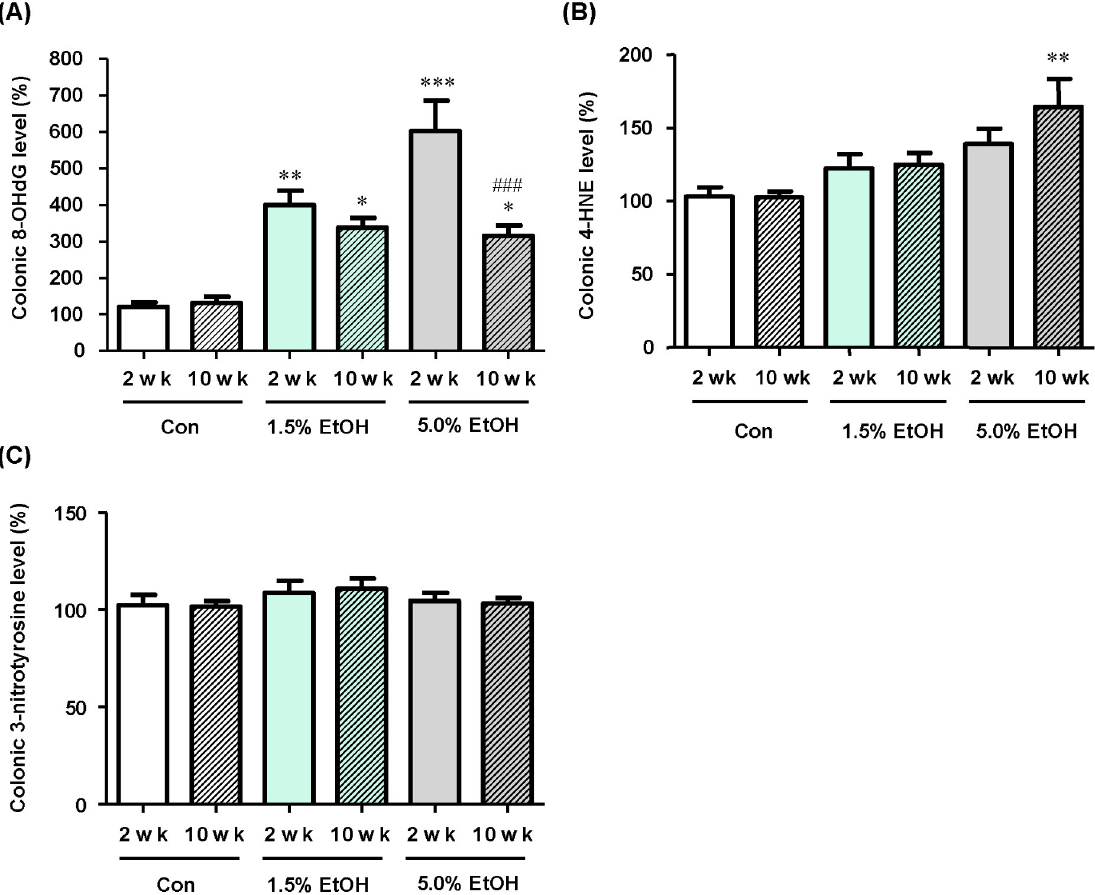
Fig 3. Effects of chronic oral administration of ethanol on the levels of colonic oxidative stress markers in mice. (A) The 8-OHdG levels in colonic tissue extracts were determined by ELISA, and the relative percentages of the 8-OHdG levels are shown with the level obtained with a 2-wk Con subject taken to be 100%. (B) The 4-HNE levels in colonic tissue extracts were determined by ELISA, and the relative percentages of the 4-HNE levels are shown with the level obtained with a 2-wk Con subject taken to be 100%. (C) The nitrotyrosine levels in colonic tissue extracts were determined by ELISA, and the relative percentages of the 3-nitrotyrosine levels are shown with the level obtained with a 2-wk Con subject taken to be 100%. The data are expressed as means ± SD (n = 5). � p < 0.05, �� p < 0.01, and ��� p < 0.001; versus 2 wk Con as assessed by ANOVA with the Tukey-Kramer test. ### p < 0.001 for 2 wk 5.0% EtOH versus 10 wk 5.0% EtOH, as assessed by the paired t -test. For abbreviations for ethanol-administration conditions, see the legend to Fig